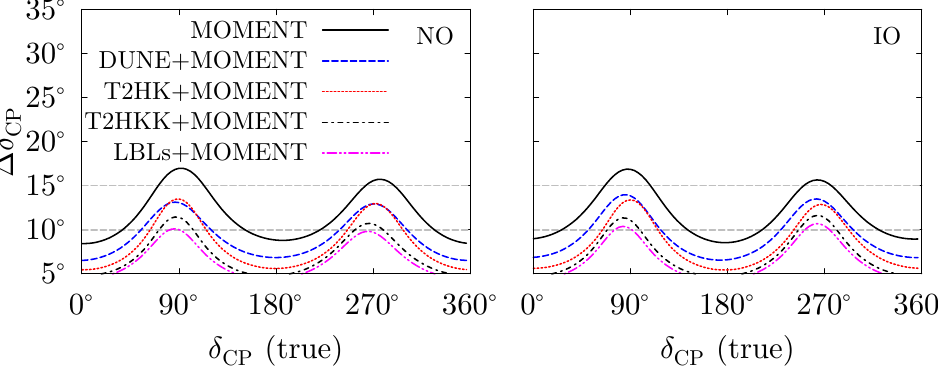
Figure 7. The 1 (cid:27) con(cid:12)dence level uncertainty of (cid:14) CP shown for four di(cid:11)erent combinations of neutrino oscillation data. The results are shown for the currently allowed values of (cid:14) CP in normal ordering (NO) and inverted ordering (IO). The grey dashed lines represent the benchmark values of (cid:1) (cid:14) CP = 10 (cid:14) and 15 (cid:14) . Here LBLs+MOMENT corresponds to the combined run of the DUNE, MOMENT and T2HKK